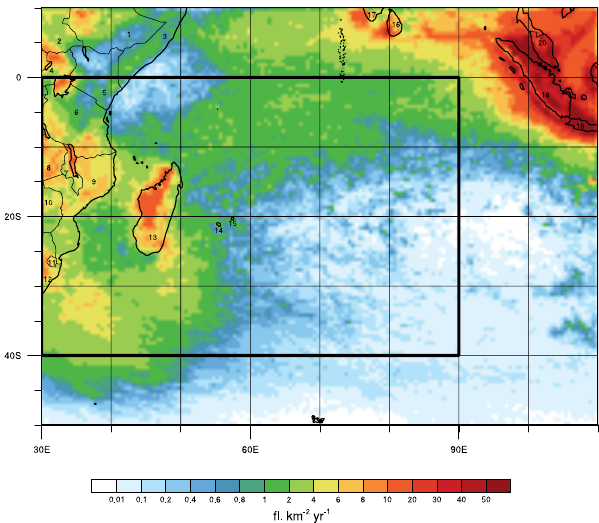
Fig. 1. Distribution of the annual mean flash density (flkm − 2 yr − 1 ) over the SWIO. The black box corresponds to the area of respon- sibility of RSMC La R´eunion. The different numbers stand for the country or region: 1-Ethiopia, 2-Sudan, 3-Somalia, 4-Uganda, 5-Kenya, 6-Tanzania, 7-Malawi, 8-Zambia, 9-Mozambique, 10- Zimbabwe, 11-Swaziland, 12-South Africa, 13-Madagascar, 14-La R´eunion, 15-Mauritius, 16-Sri Lanka, 17-India, 18-Sumatra, 19- Java and